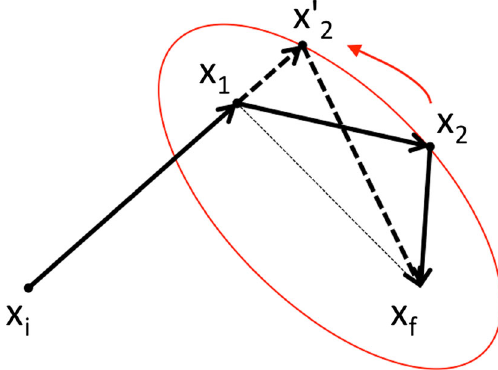
Fig. 4 Relativistic PI with two intermediate